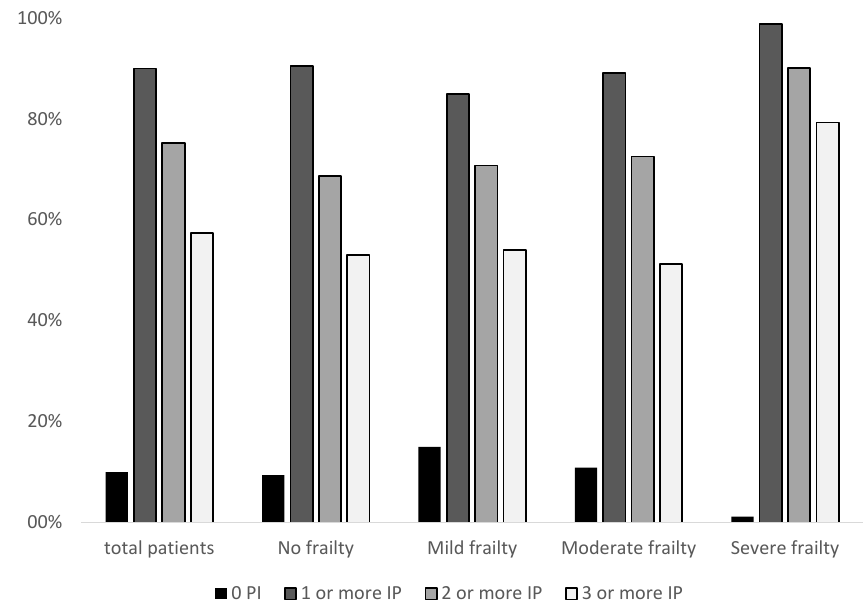
Figure 2. Number of inappropriate prescriptions (IP) according to the frailty index